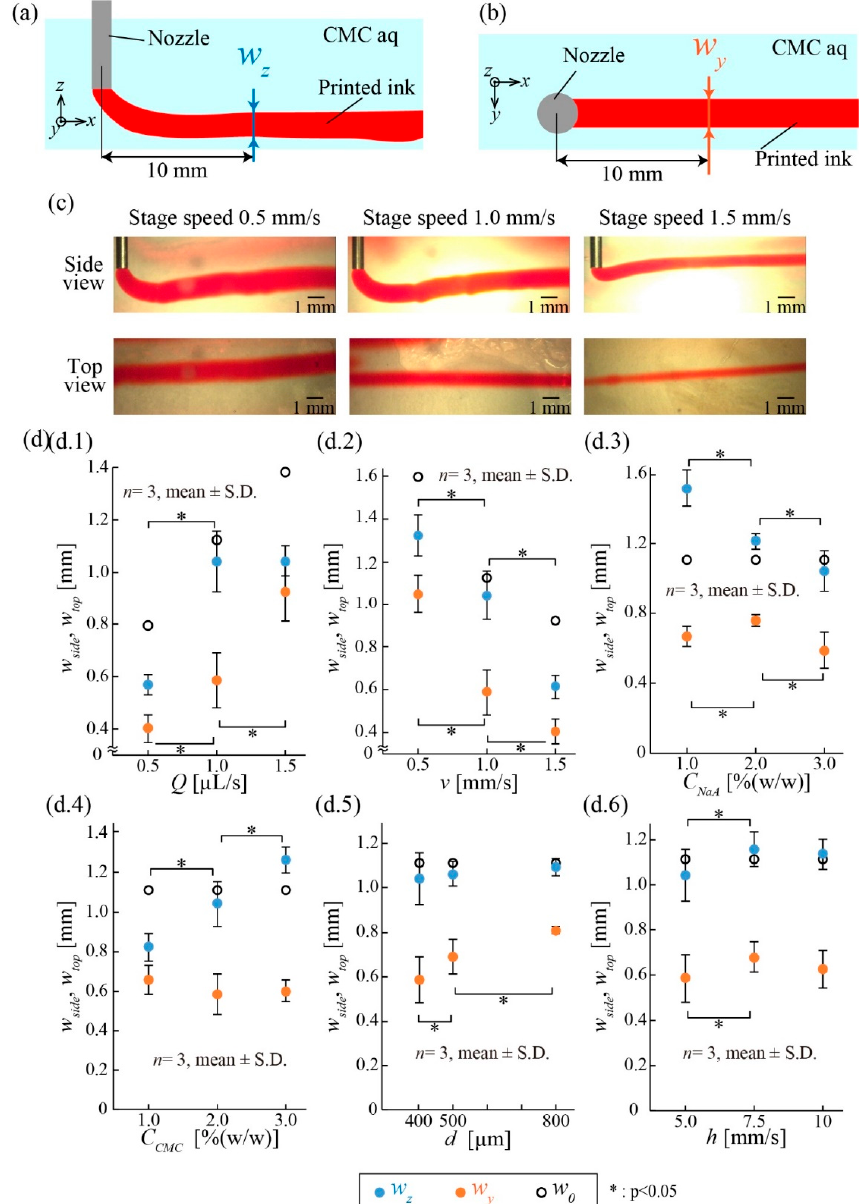
Figure 4. Measurement of the width of the printed ink in the supporting viscous liquid. ( a ) w z is defined as the z -axis width of the printed ink at 10 mm away from the nozzle. ( b ) w y is defined as the y -axis width of printed ink at 10 mm away from the nozzle. ( c ) Images of the printed ink with various stage speeds. w z and w y decreased as the stage speed increased. ( d ) w z and w y under various conditions. w z and w y can be mainly controlled by the flow rate and stage speed.